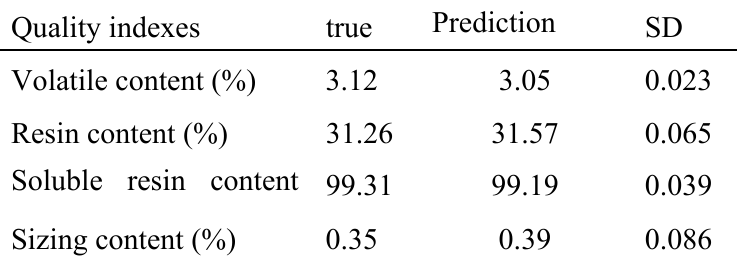
Table 4 . The repeatability of NIR methods.